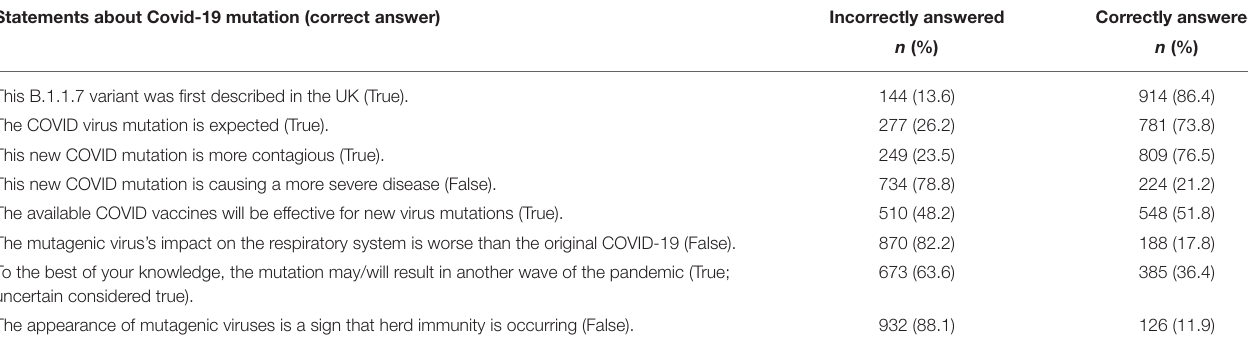
TABLE 3 | Indicators for HCWs’ awareness of/knowledge about the COVID-19 pandemic and its mutations. Statements about Covid-19 mutation (correct